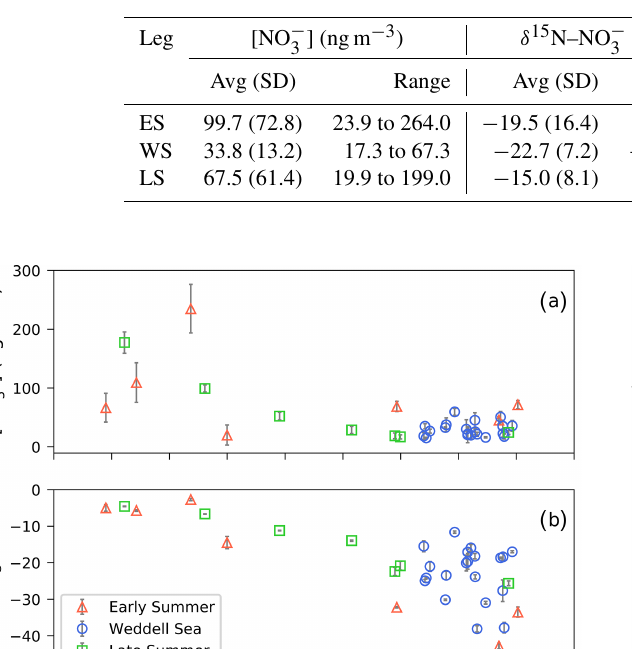
− ]; 3 and δ 18 O–NO − ; ‰) are shown. 3 3